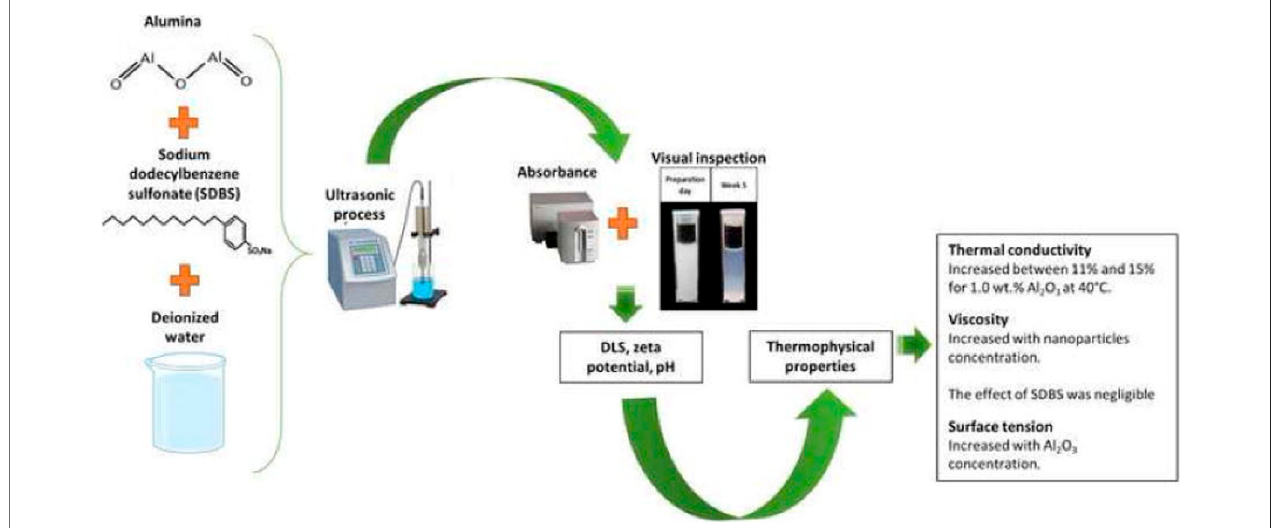
FIGURE 2 | Schematic Illustration of water-Al 2 O 3 based nano fl uids using SDBS as dispersant agent (Gallego et al., 2020).